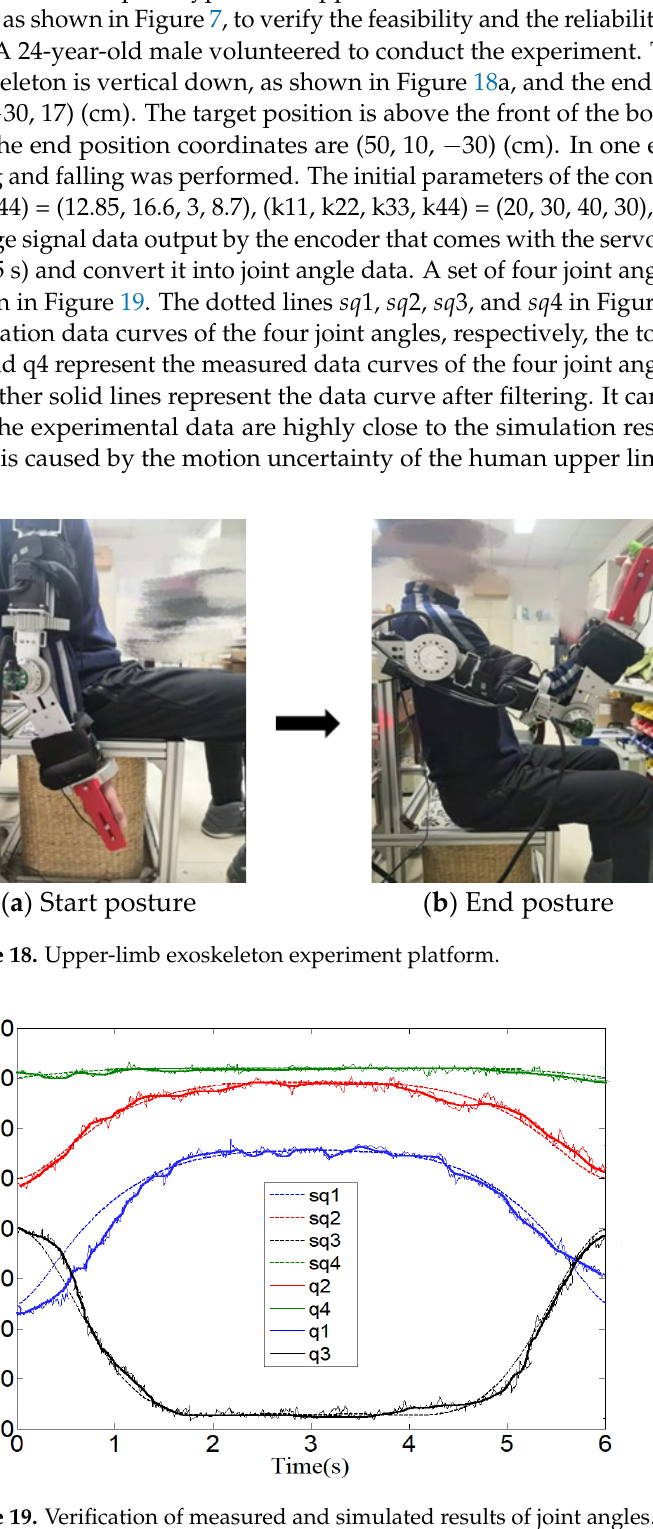
Figure 19. Verification of measured and simulated results of joint angles.